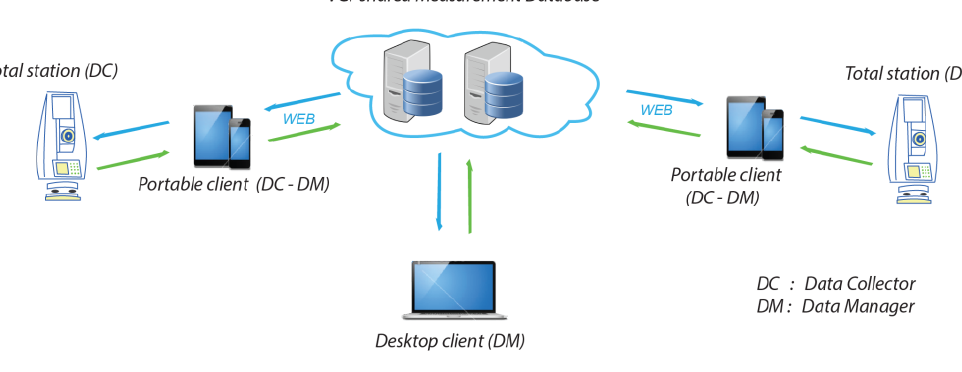
Figure 1: Networked measurement stations, VGI database, and data